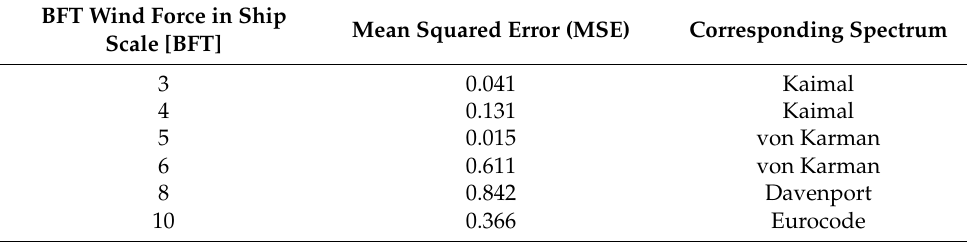
Figure 24. Strong wind (10 BFT in ship scale) compared to Eurocode spectrum. Table 4. Quantitative analysis of data fit to standard